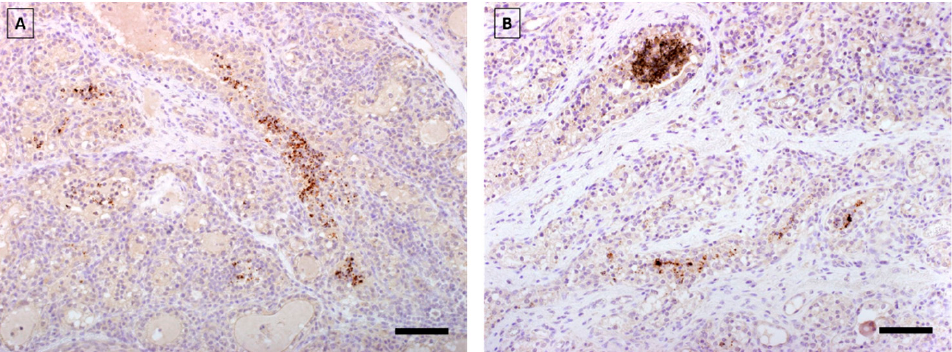
Figure 6. Immunohistochemical detection of M. agalactiae in left udder samples of PLMV-infected ( A ) and PLMX-infected ( B ) sheep. M. agalactiae specific brown reaction products are observed using anti- M. agalactiae -specific rabbit polyclonal antibodies (bar = 80 µm).